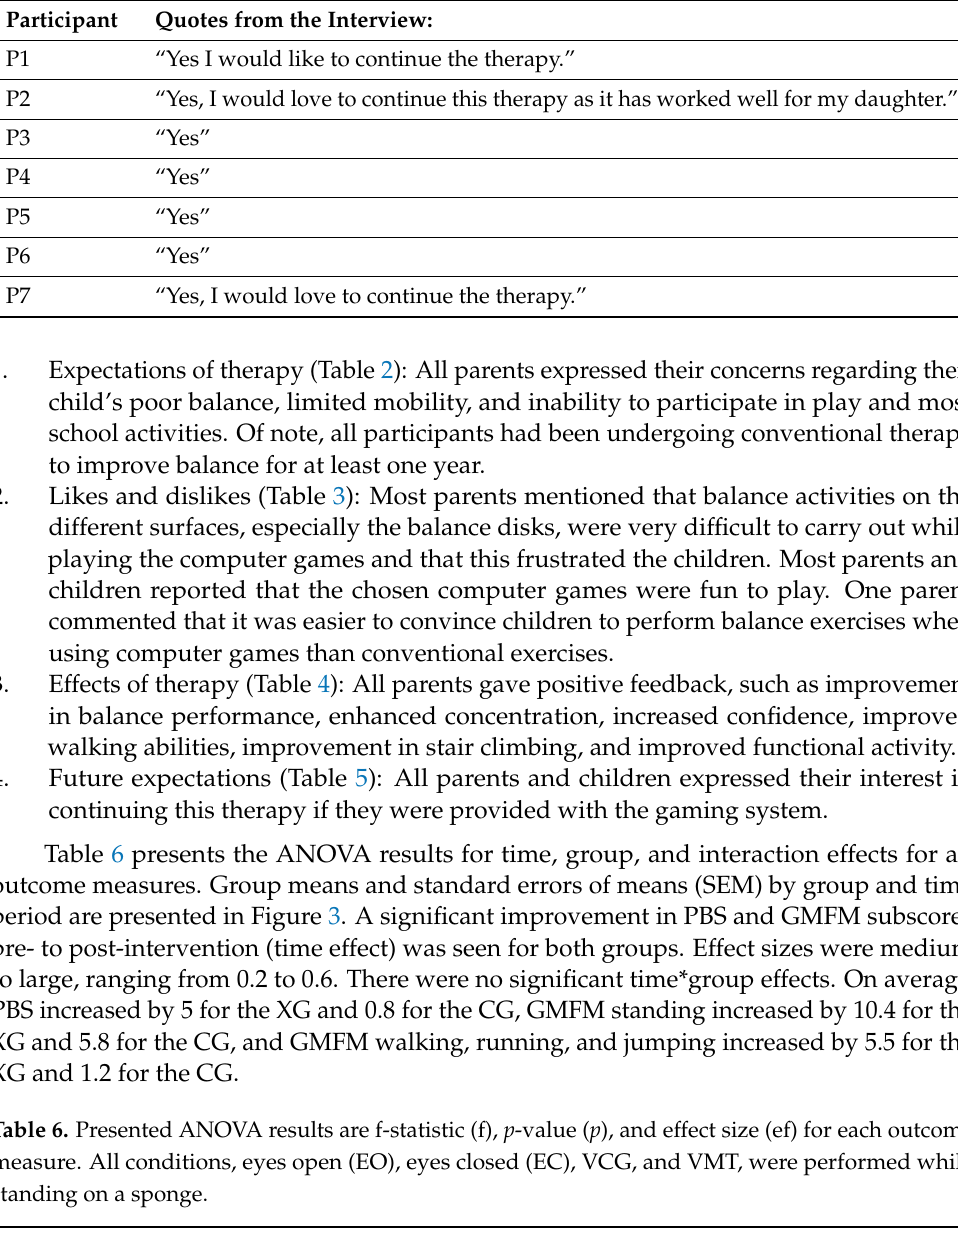
Table 5. Future expectations.